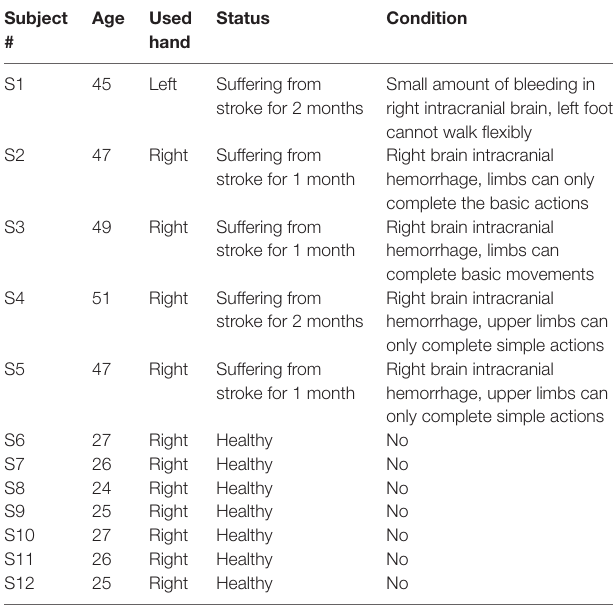
TaBle 1 | Demographic information the